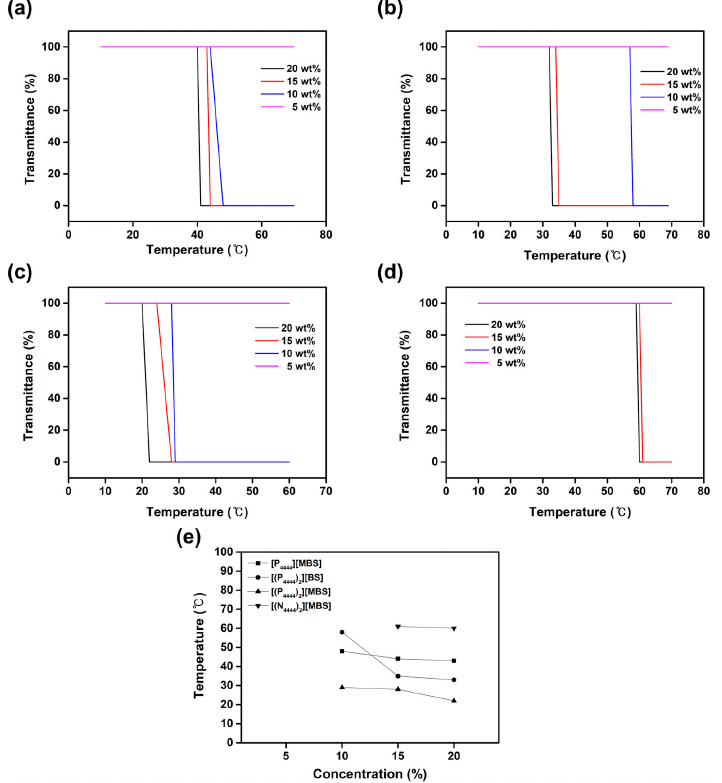
Figure 7. Transmittance curve of ( a ) [P 4444 ][MBS], ( b ) [(P 4444 ) 2 ][BS], ( c ) [(P 4444 ) 2 ][MBS], and ( d ) [(N 4444 ) 2 ][MBS] according to the temperature change using UV-Vis spectrophotometer. ( e ) Phase